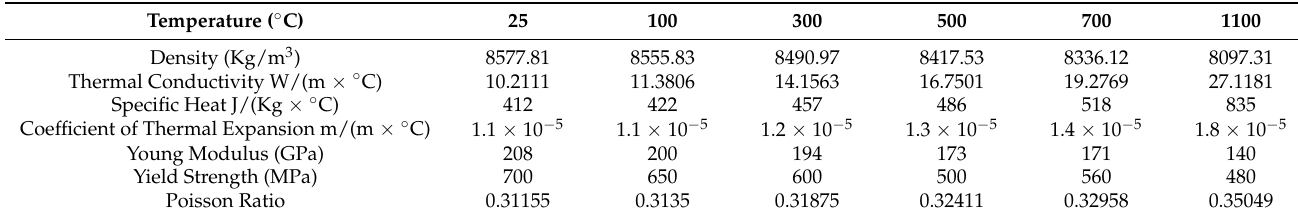
Table 3. Temperature-dependent material properties for solid Inconel ® 718.